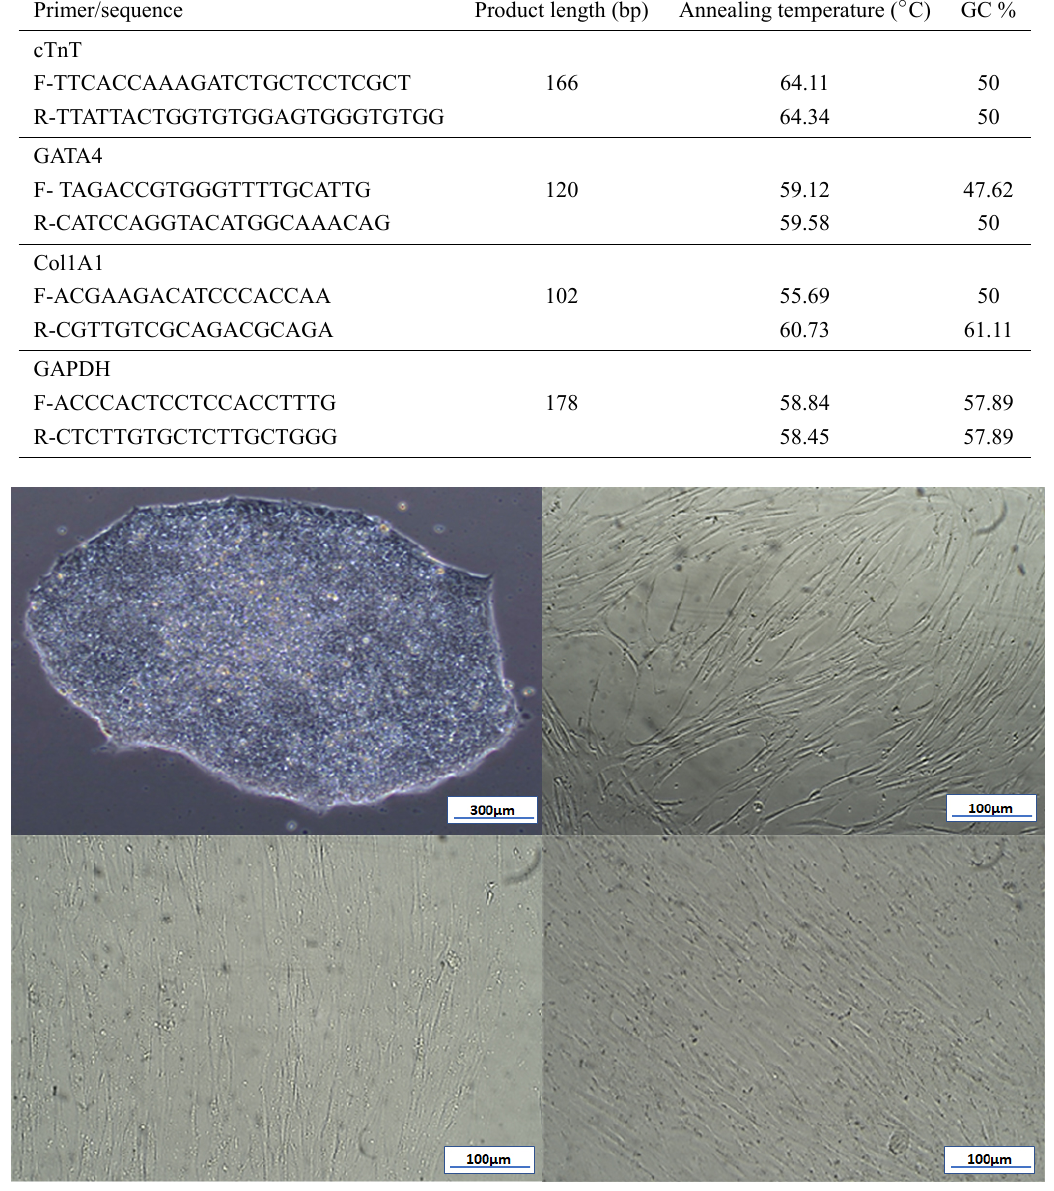
Table 1. Primer sequences of cardiomyocytes specific genes.